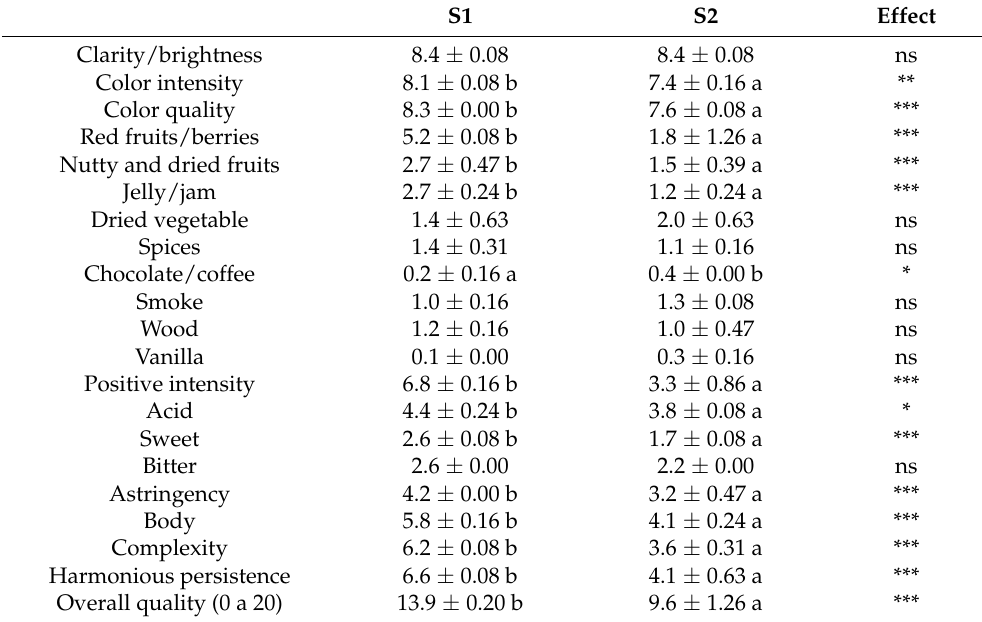
Table 4. ANOVA results used to evaluate the site effect on each sensory descriptor of the wines obtained. Values are the average of the replicates (average ± std.